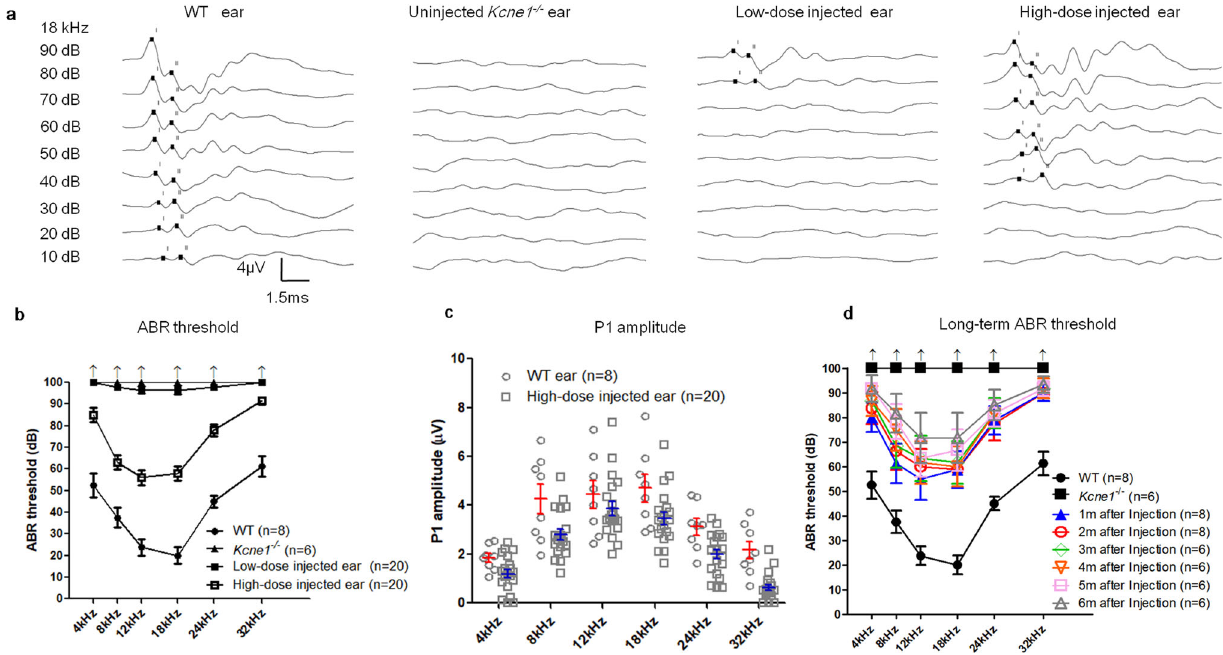
Fig. 6 Comparison of auditory brainstem response (ABR) data measured from WT, untreated, and treated Kcne1 − / − mice ( n ≥ 6 in each group). a Series of representative waveforms of ABRs elicited by different intensities of tone burst (at 18 kHz) are given for WT, untreated, and low- and high-dose- treated Kcne1 − / − mice (as labeled). b Averaged ABR thresholds at various frequencies for different groups of mice as indicated by the fi gure legends. Data are shown as mean ± SEM. Upward arrows indicate that ABR thresholds were at the maximal sound level that could be measured by our equipment. Source data are provided as a Source data fi le. c The peak amplitude of ABR wave 1 (P1) elicited at 90 dB SPL from 4 to 32 kHz. Source data are provided as a Source data fi le. d Changes in ABR thresholds of high-dose-injected Kcne1 − / − ears measured at 1 – 6 months after injections. Data are shown as mean ± SEM. Source data are provided as a Source data fi